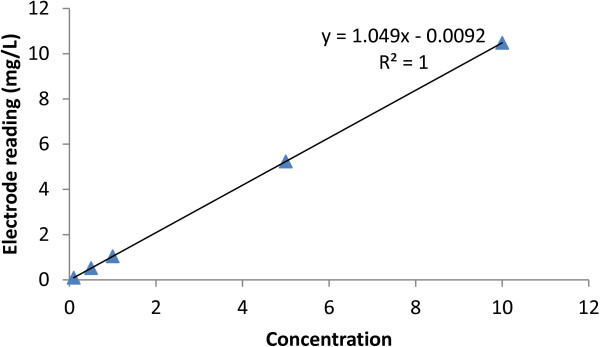
Calibration curve.